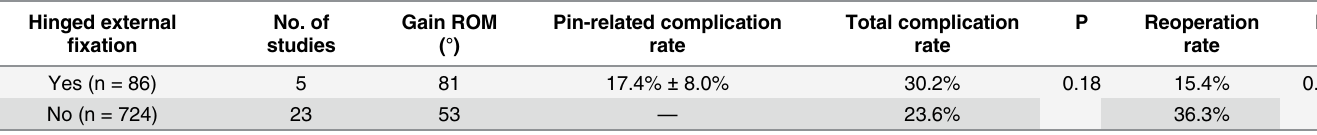
Table 4. Summary of patients treated with and without hinged external fixation. Hinged external fi